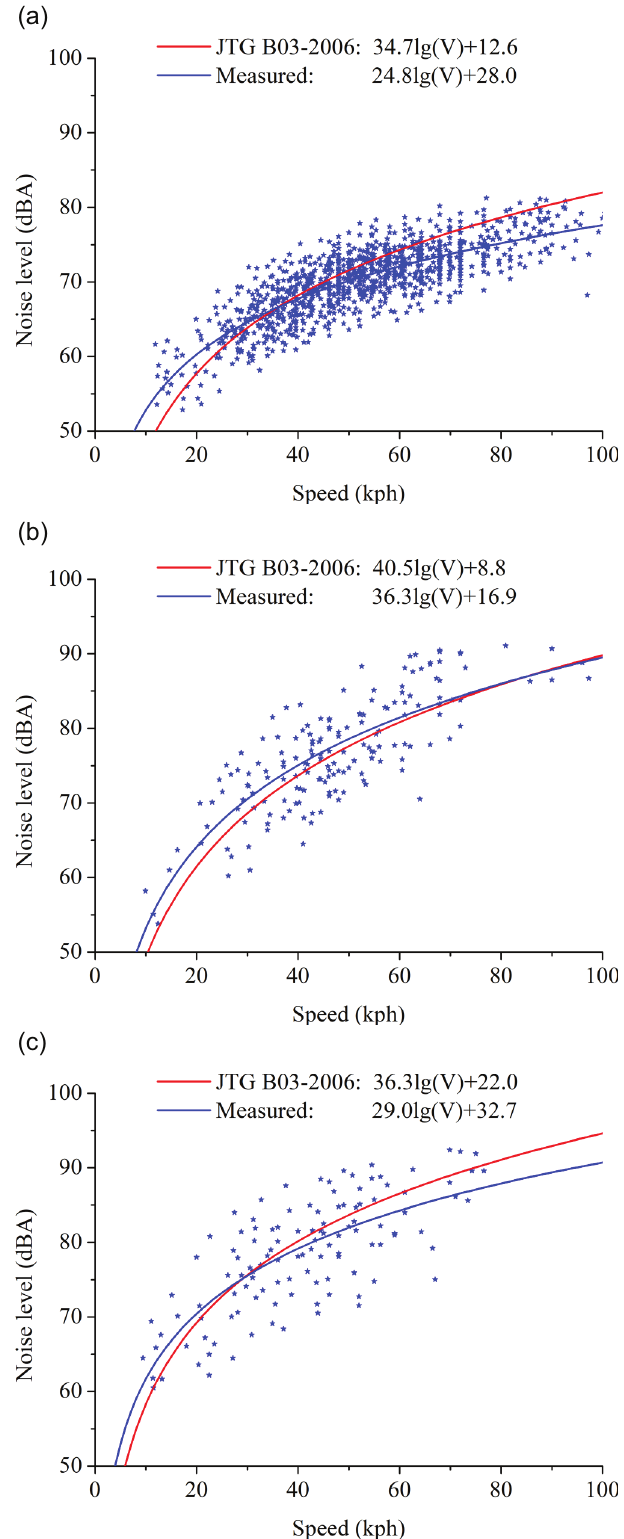
Figure 2. The regression curve between vehicle speed and noise emissions based on measured data. (a) Light vehicles; (b) medium vehicles; (c) heavy